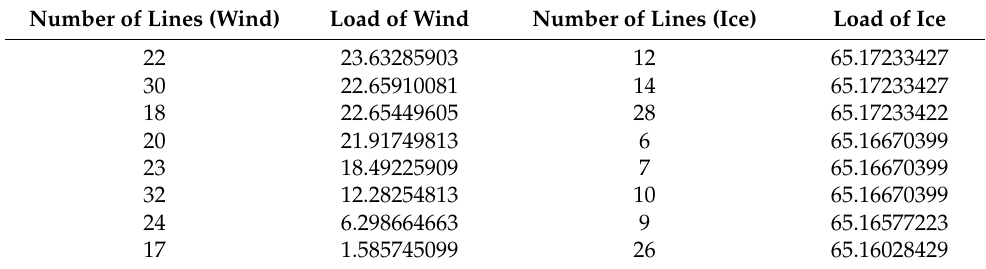
Table 5. Load of wind and ice of highest 8 lines in IEEE-118 during this process. Number of Lines